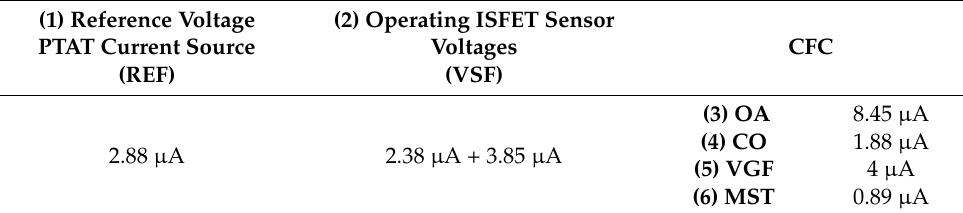
Table 3. Power activation matrix and power consumption of each block.